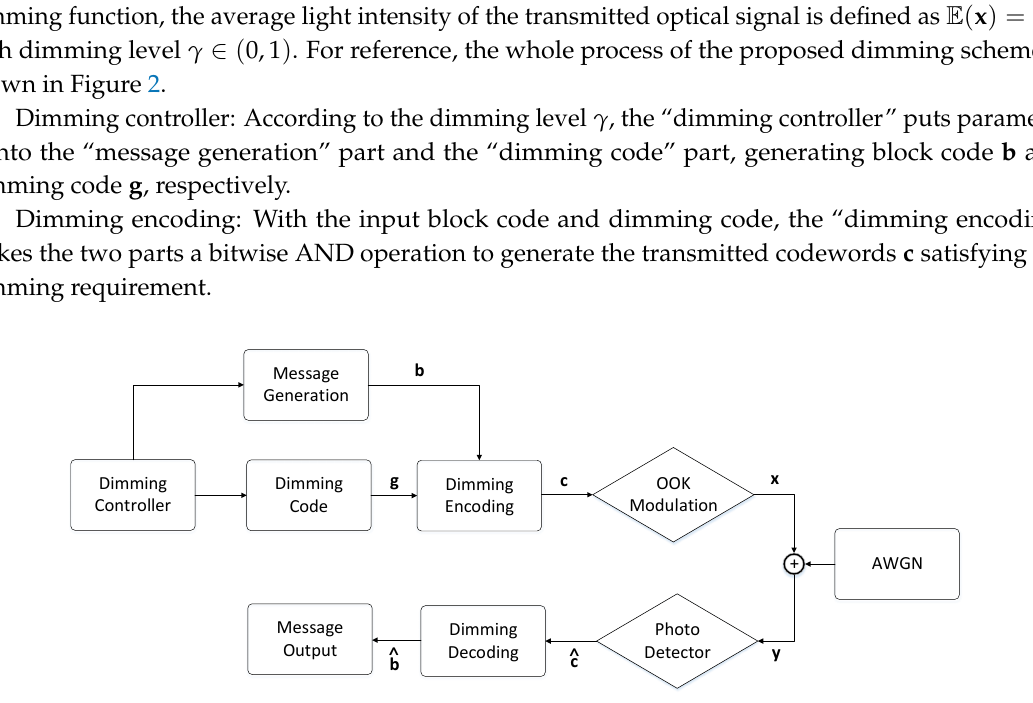
Figure 2. Block diagram of the proposed scheme. OOK, on-off